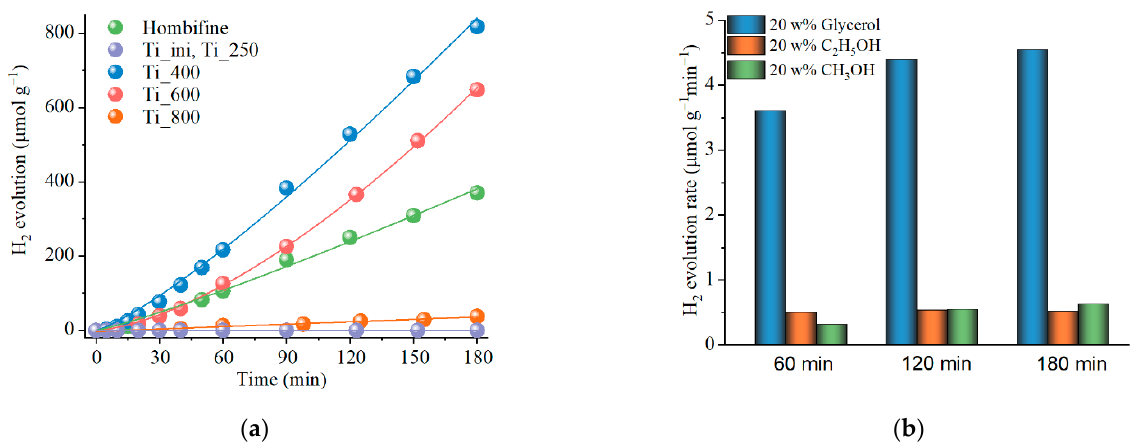
Figure 3. ( a ) HER in the presence of different Ti_x samples (glycerol, as a sacrificial agent); ( b ) the H 2 evolution rate for Ti_400 in the presence of various sacrificial agents under LED 375 nm source. The dependences of the efficiency of hydrogen evolution at different catalyst load-